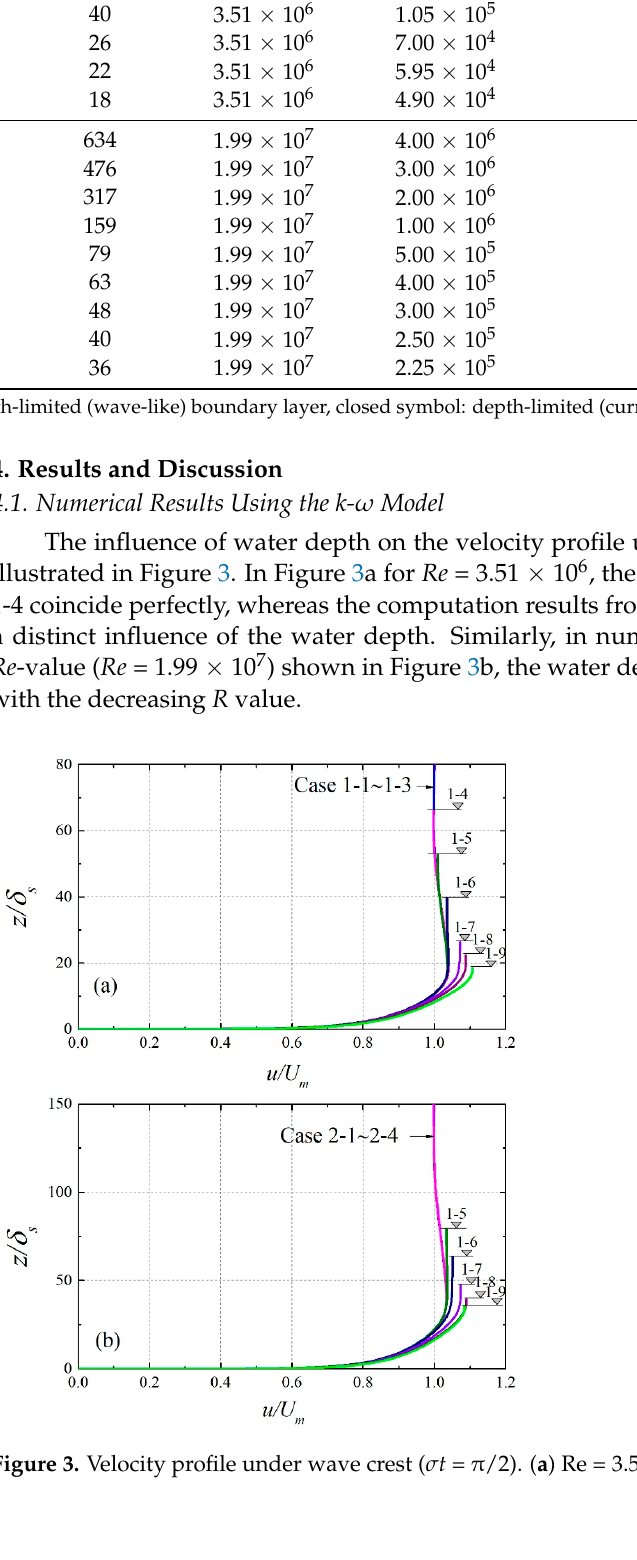
Figure 4. Time-variation of dimensionless bottom shear stress (cid:2028) ∗ ((cid:1872)) .